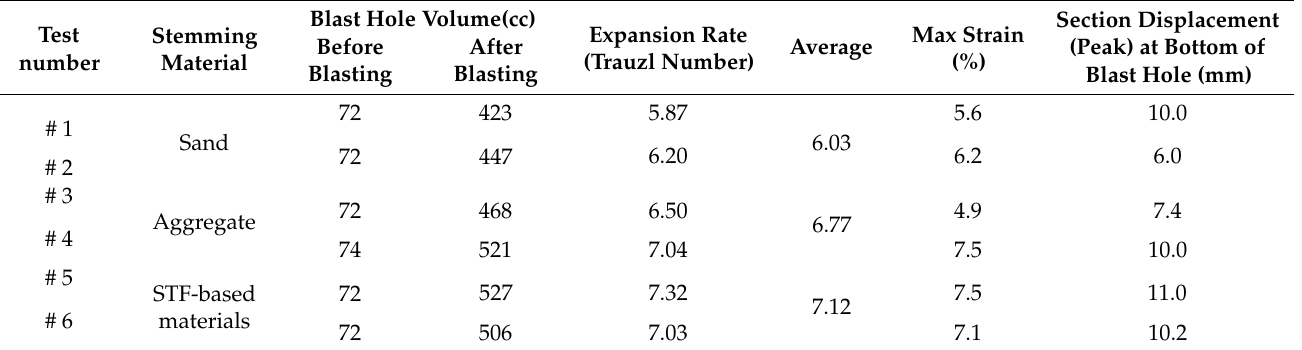
Table 5. Results of the Trauzl lead block test.